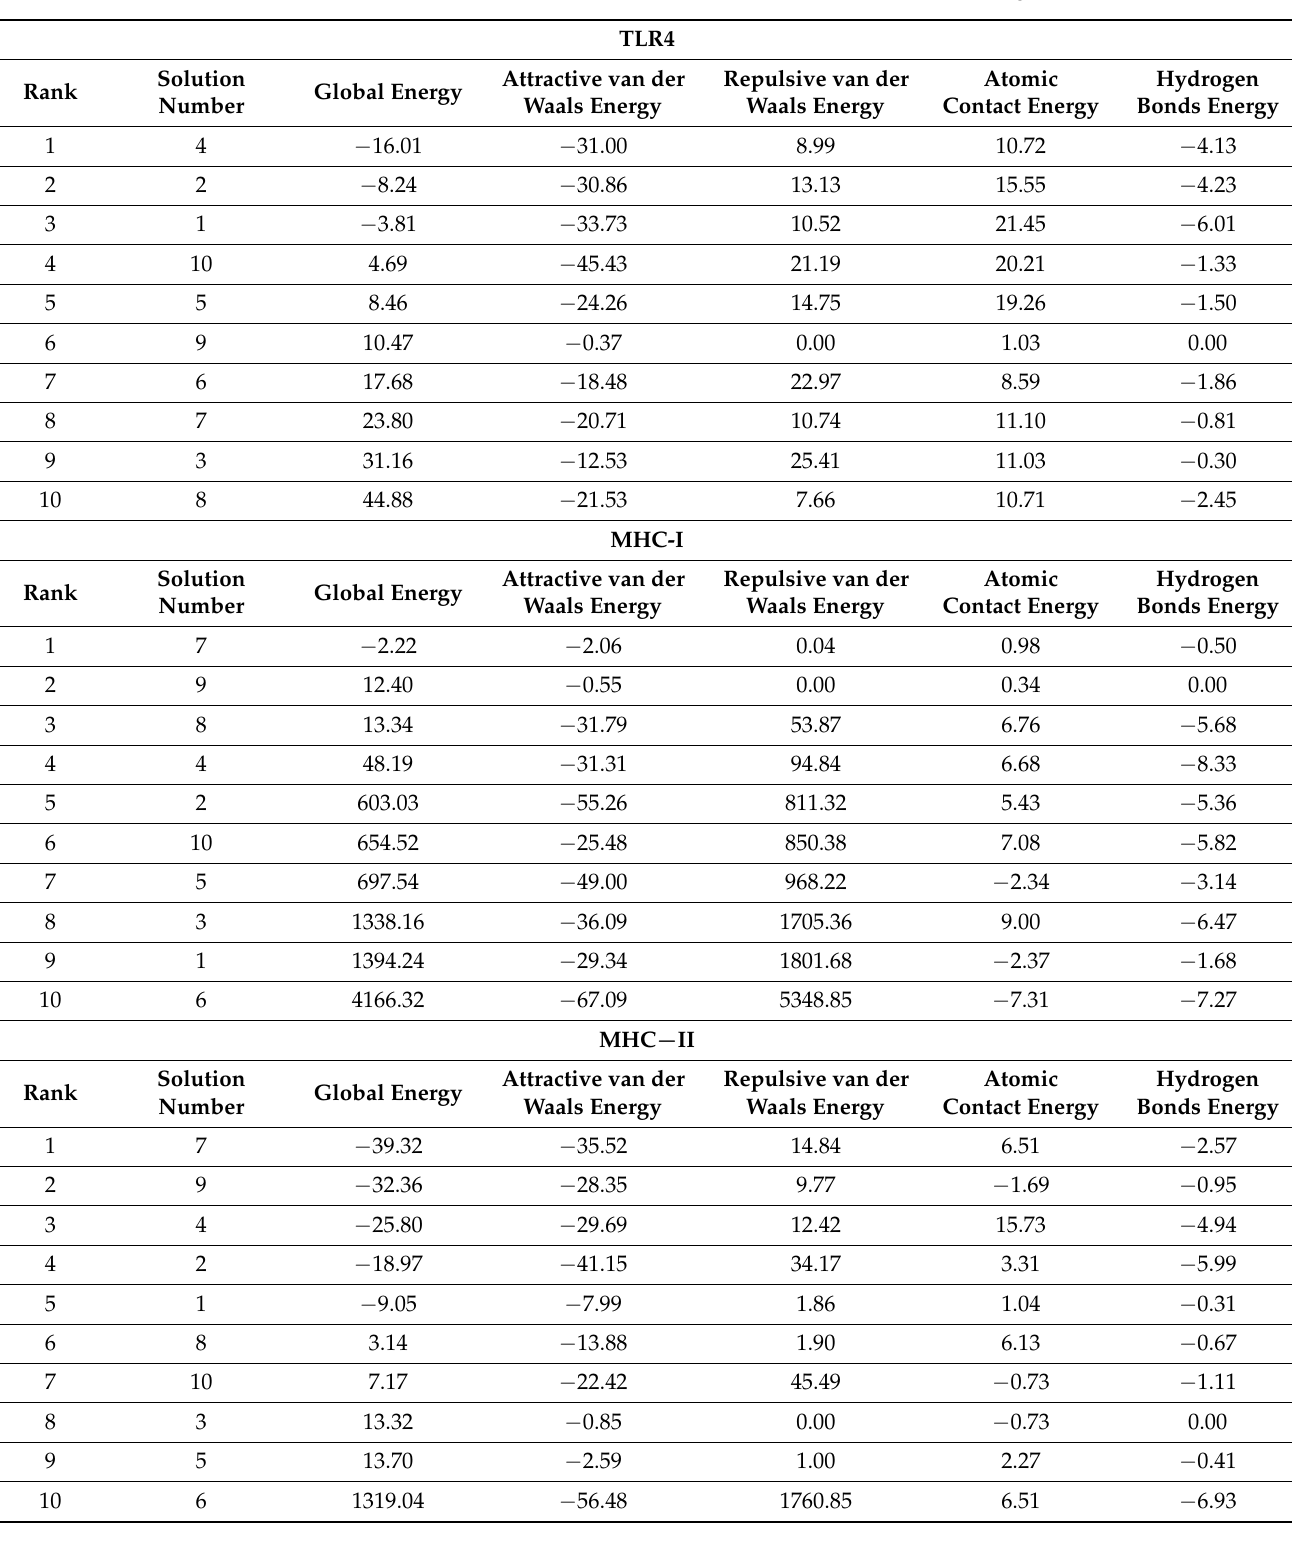
Table 4. Refined docked solutions of vaccine with TLR4, MHC-I, and MHC-II. All values are given in kcal/mol.